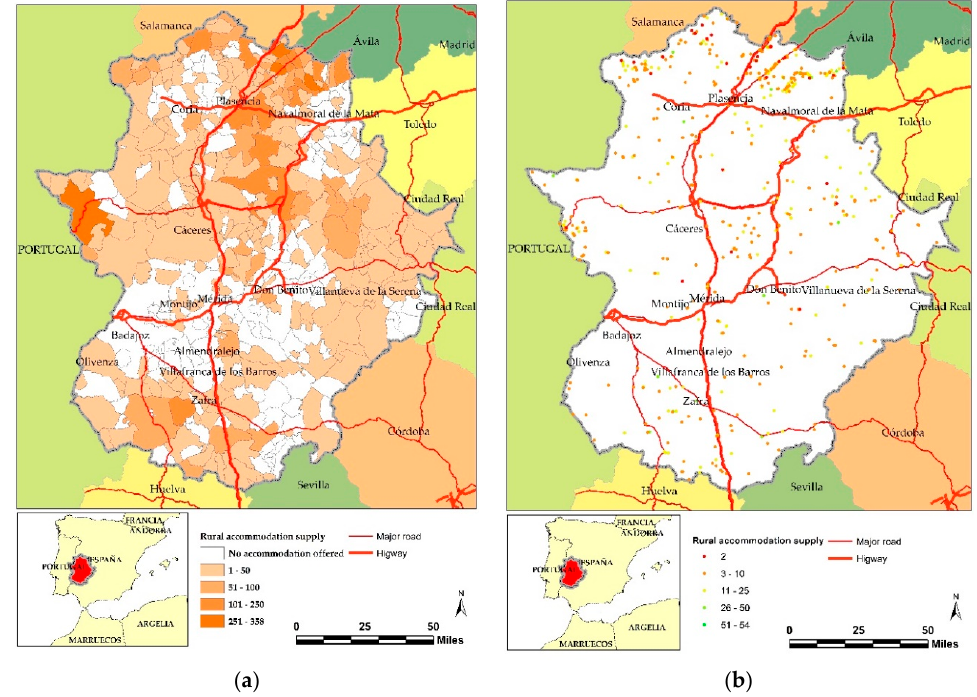
Figure 1. Study area and main roadways, represented in terms of the distribution of rural lodging capacity based on the municipality ( a ) and the number of accommodation businesses. ( b ) Data for 2018.